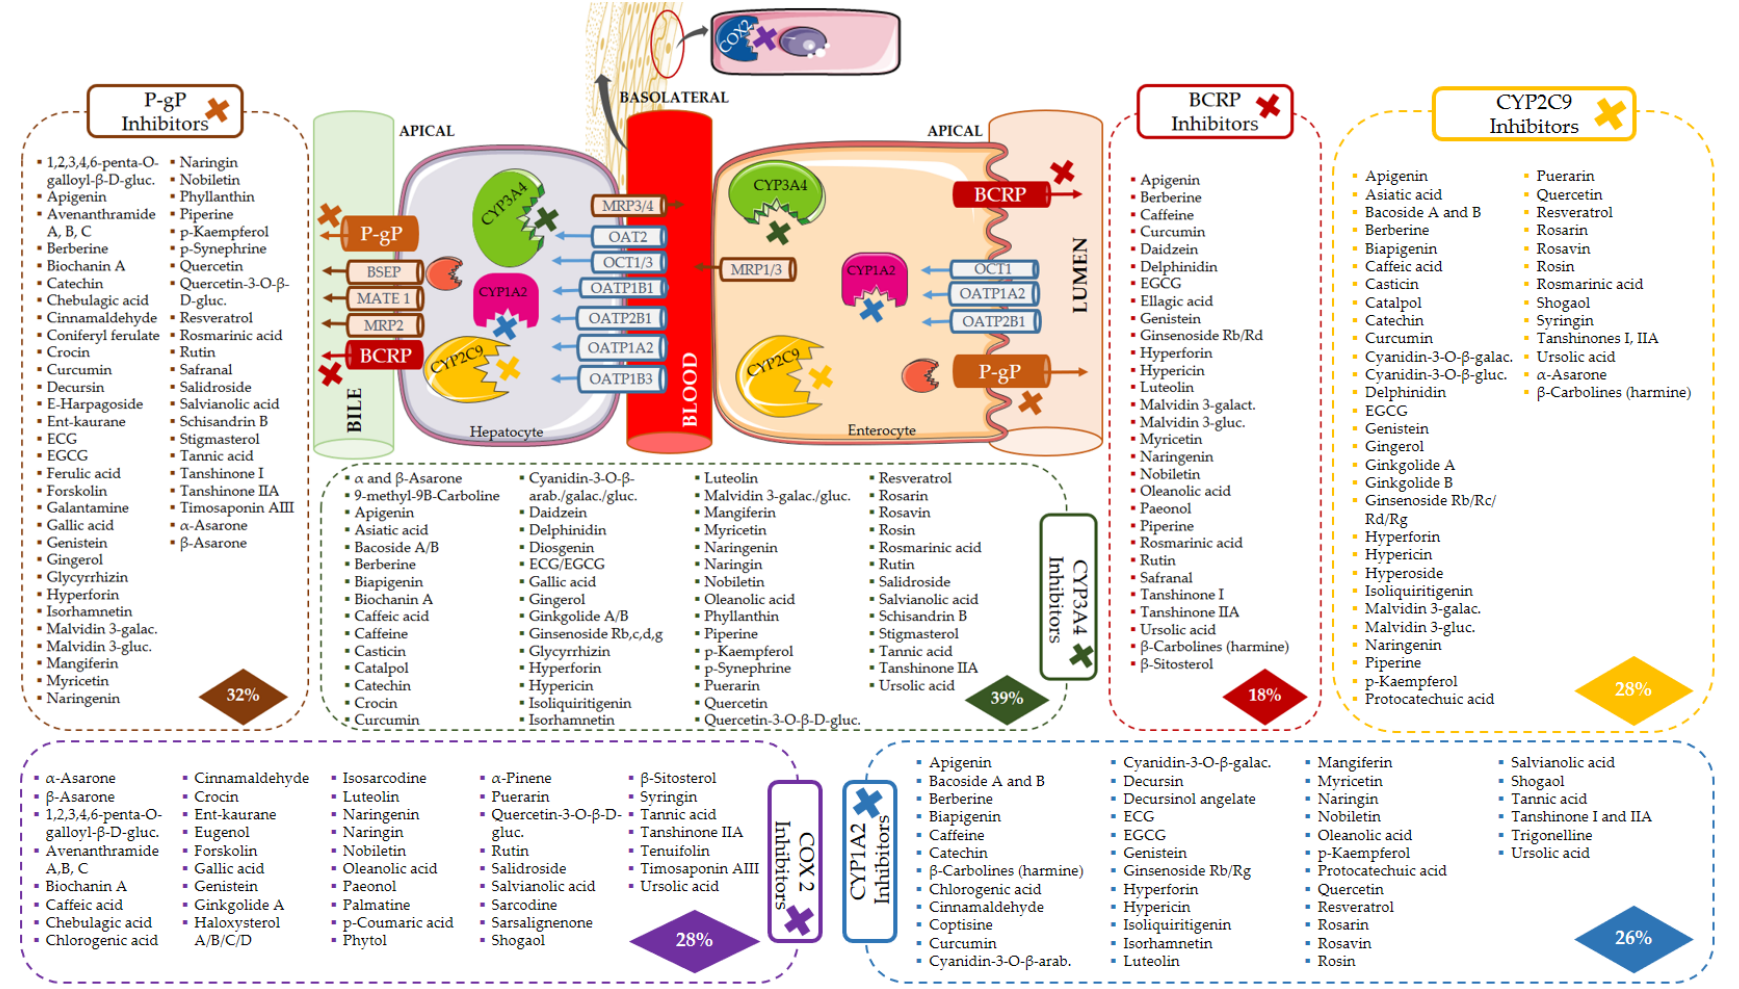
Figure 7. Bioactives that inhibit the six most affected targets (COX2, CYP1A2, CYP3A4, CYP2C9, BCRP, and P-gP). Location of the targets is indicative, since they are expressed in several other tissues.